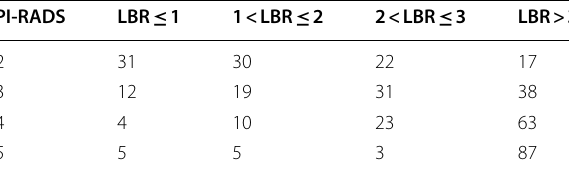
Data are described in percentage (%)